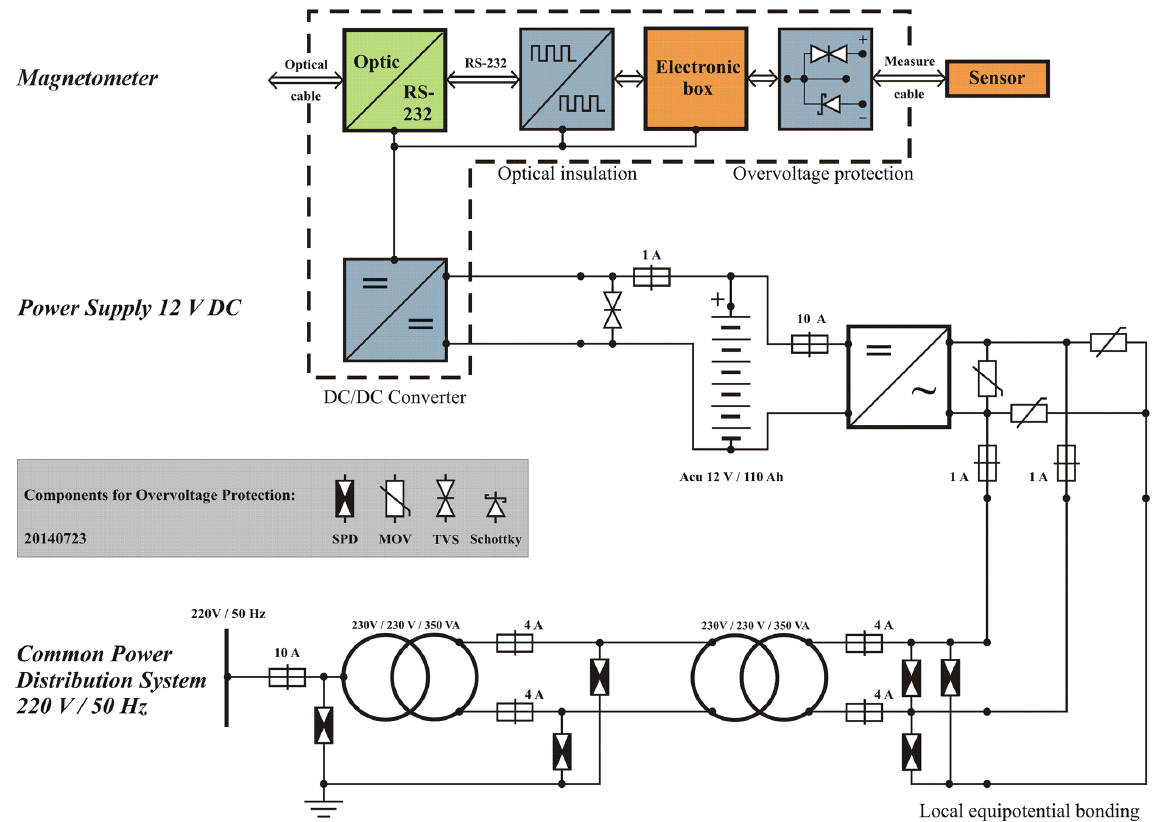
Figure 3. Flow diagram of the connection of the variometer on the low-voltage power supply network and its protection against